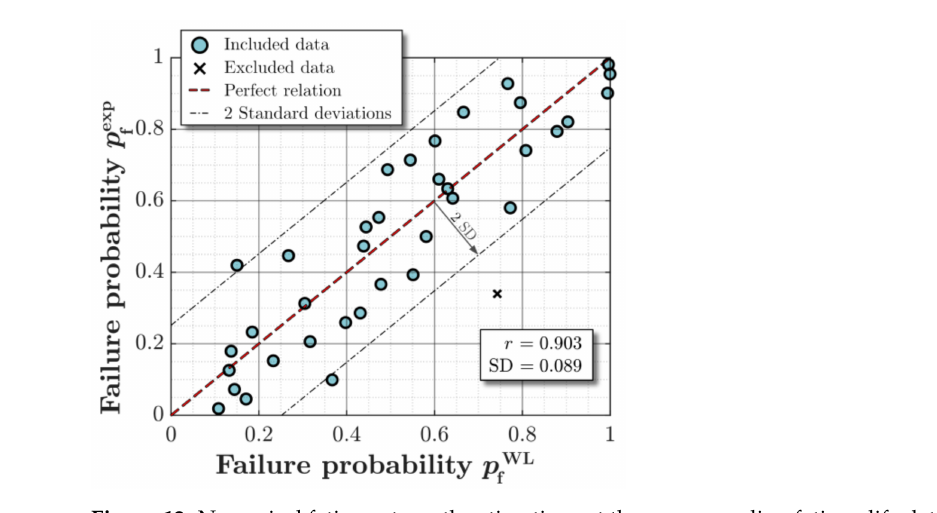
Figure 12. Numerical fatigue strength estimations at the corresponding fatigue life determined from experimental testing.